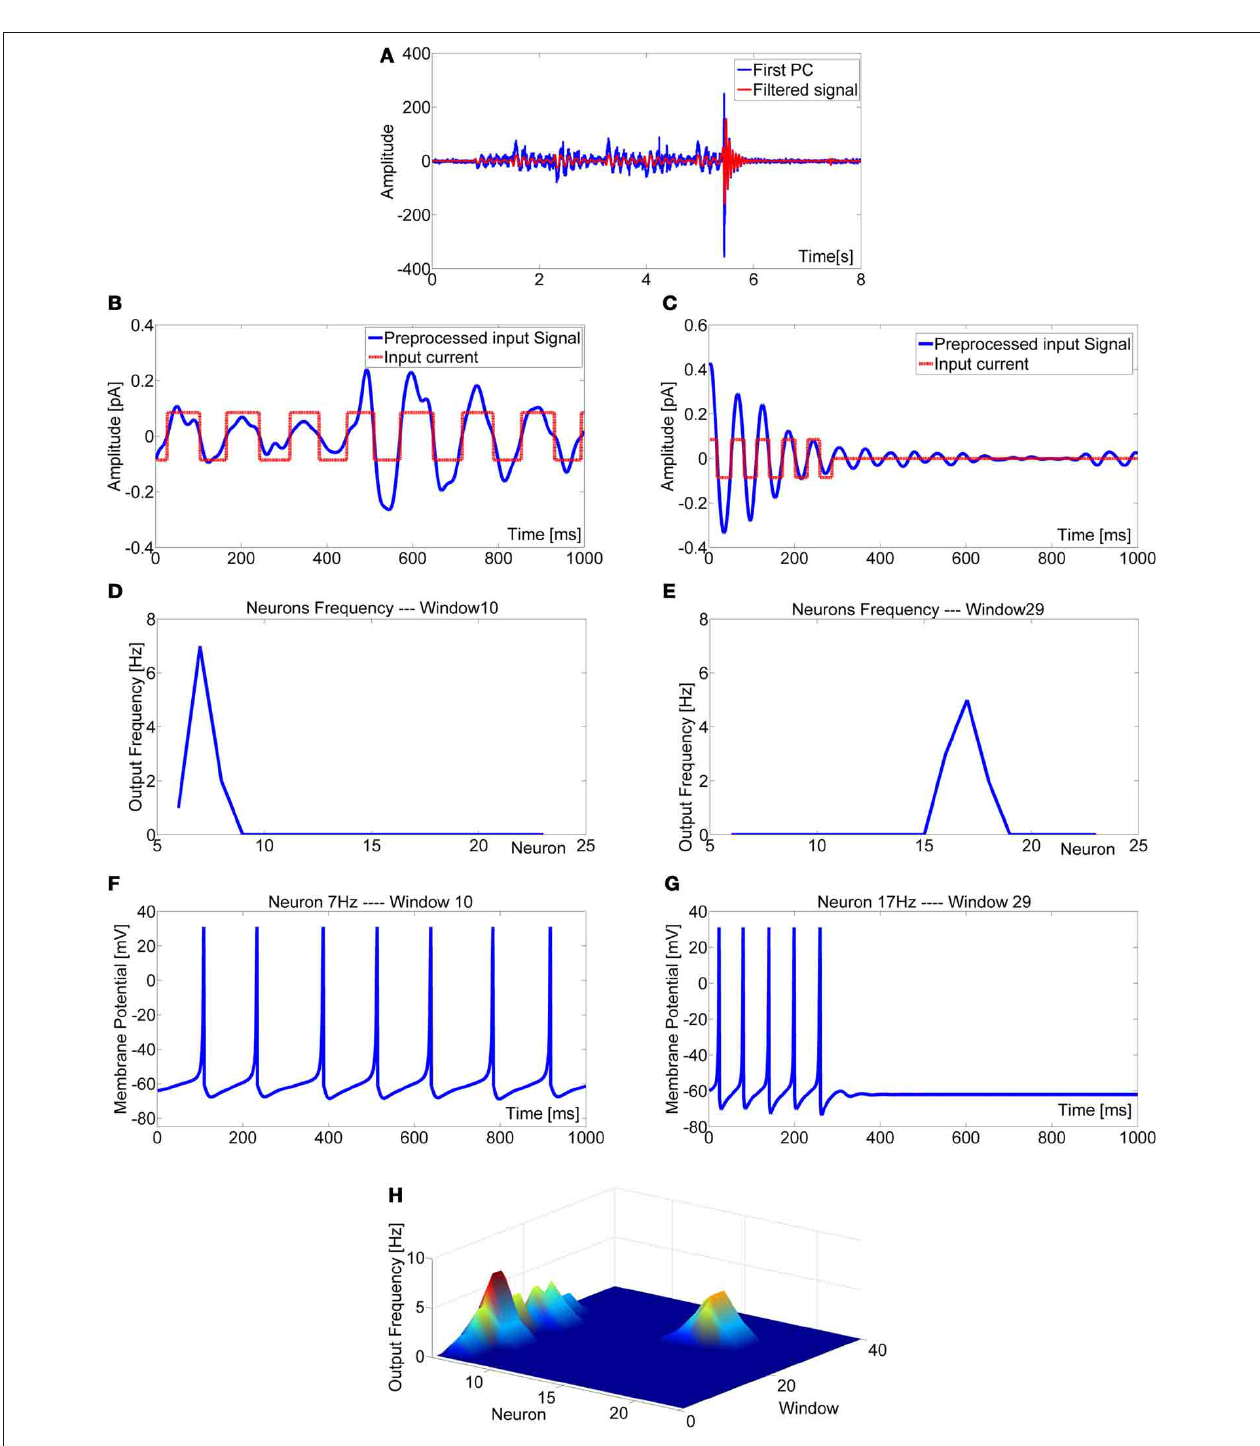
FIGURE 10 | Experimentperformedwiththerobotexploringa flatterrain atlow speed.(A) Principal component extracted from the acceleration data and filtered signal (after low-pass-filtering with a cut-off frequency of 30Hz). Behavior of the network in absence of contact events: (B) normalized signal in the interval [2, 3]s (window10); (D) spike rate of the sensory array of resonate neurons: the7Hzneuronisactivebecausetherobotisinmotion; (F) membrane potential of the 7Hz neuron. Behavior of the network in presence of a contact